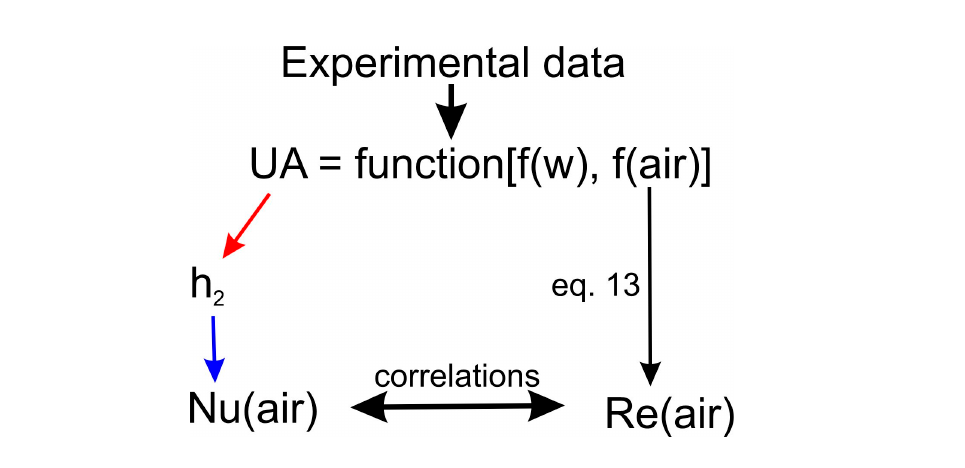
Figure 6. Algorithm finding of correlations between Nu and Re using experimental data.